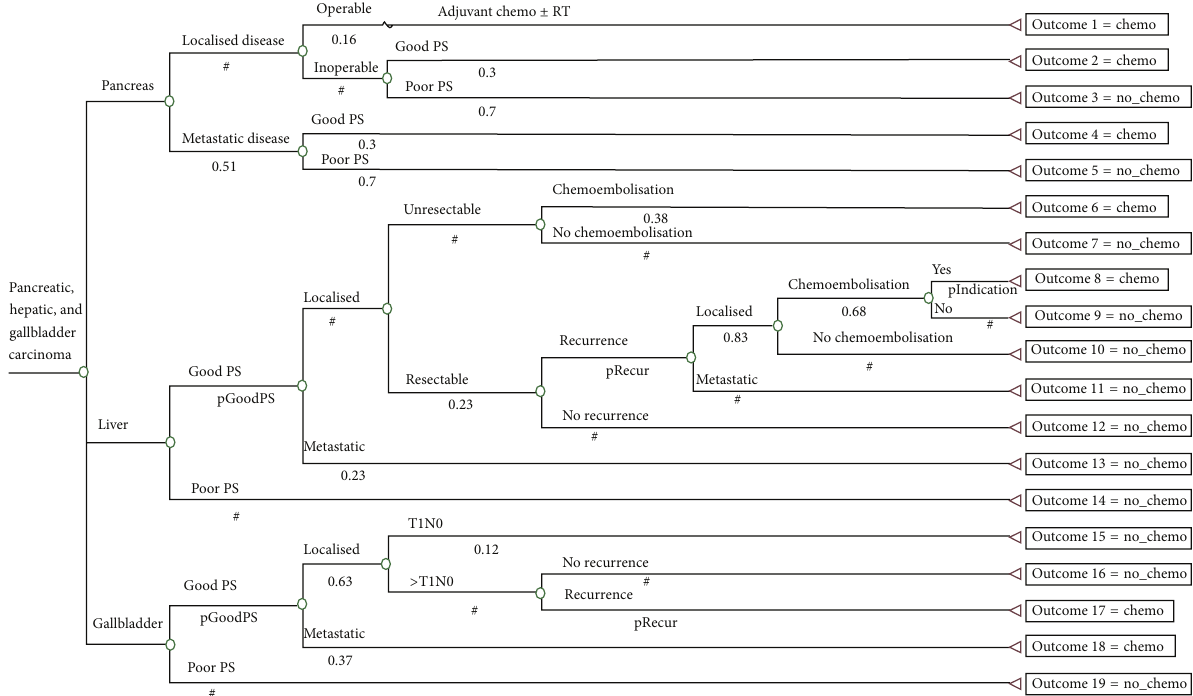
Figure 2: Optimal chemotherapy utilisation tree for pancreatic, liver, and gallbladder